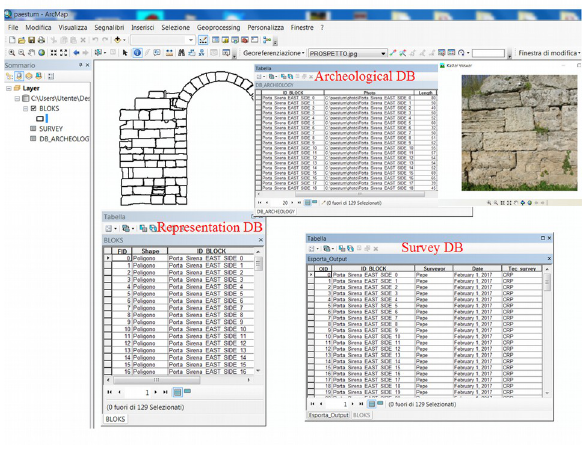
Figure 4. Vector representation in CAD environment of eastern façade of “ Porta Sirena”